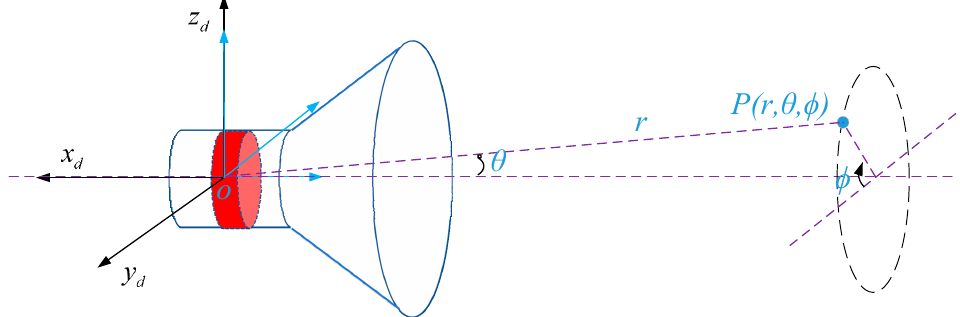
Figure 1. The spherical coordinate and fixed rectangular coordinate defined in the DS. The red part indicates the transmitting coil, which is installed on the DS. The origin of the spherical coordinate system and fixed coordinate system are established on the center point of the coil. The direction of the x -axis and z -axis in the fixed coordinates points to the back and vertically above the DS, respectively.